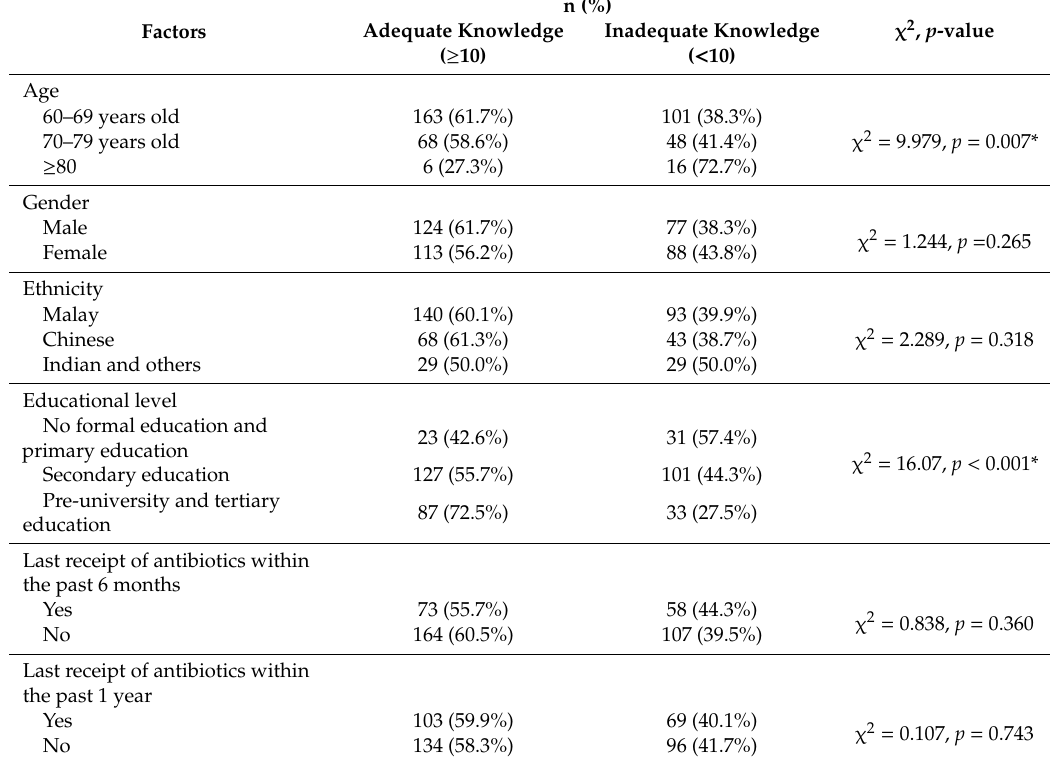
Table 7. Association between factors and respondents’ knowledge on antibiotics (n =